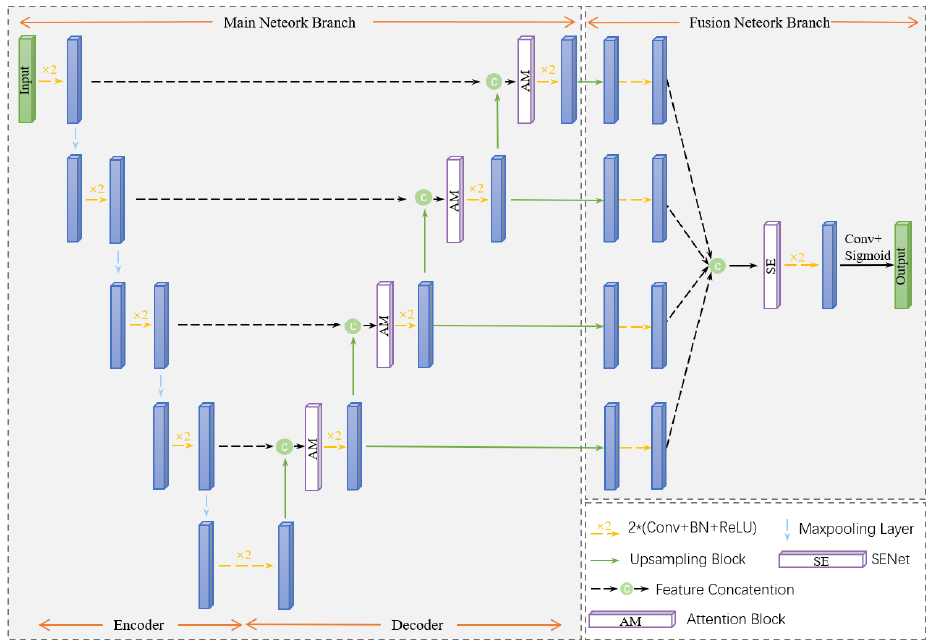
Figure 1. Y-UNet structure. Each blue rectangle corresponds to a multi-channel feature map.